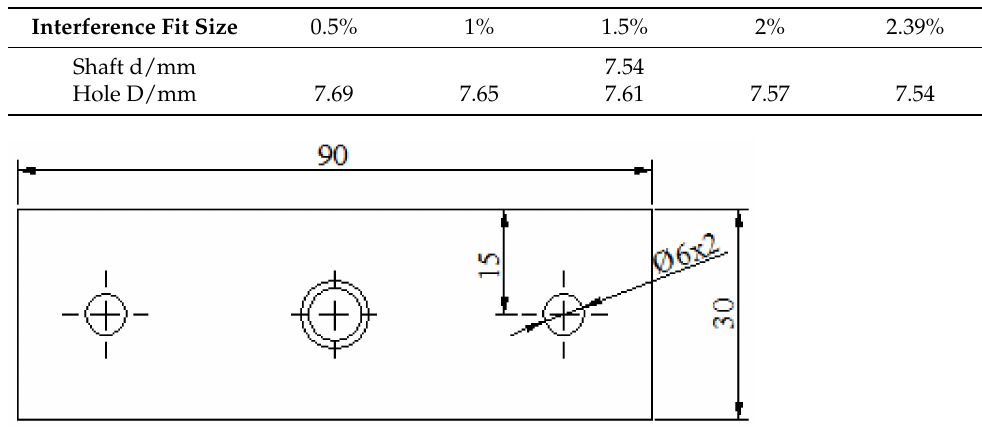
Table 5. Size of the hole and shaft with different interference fit sizes.